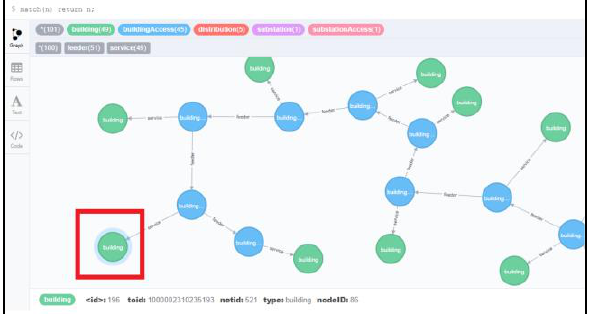
Figure 8. An electricity distribution network, used as an example to show how infrastructure networks are stored as a property graph in Neo4j.